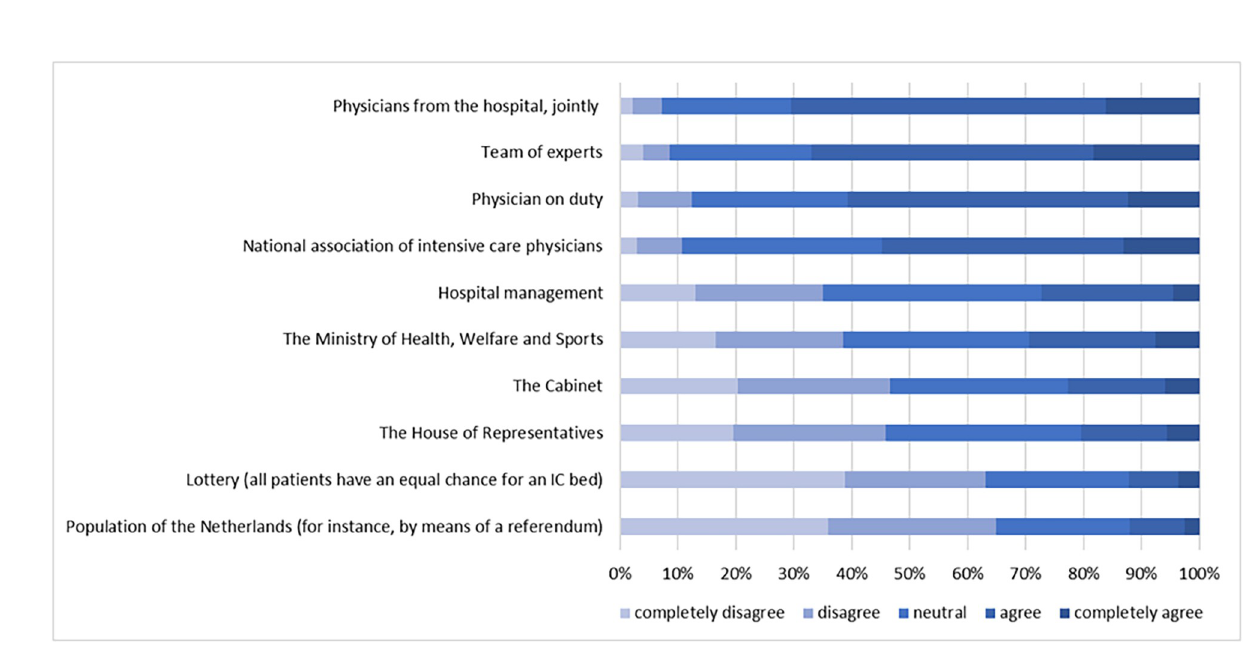
Fig 1. Support for decision-making categories, ranked by